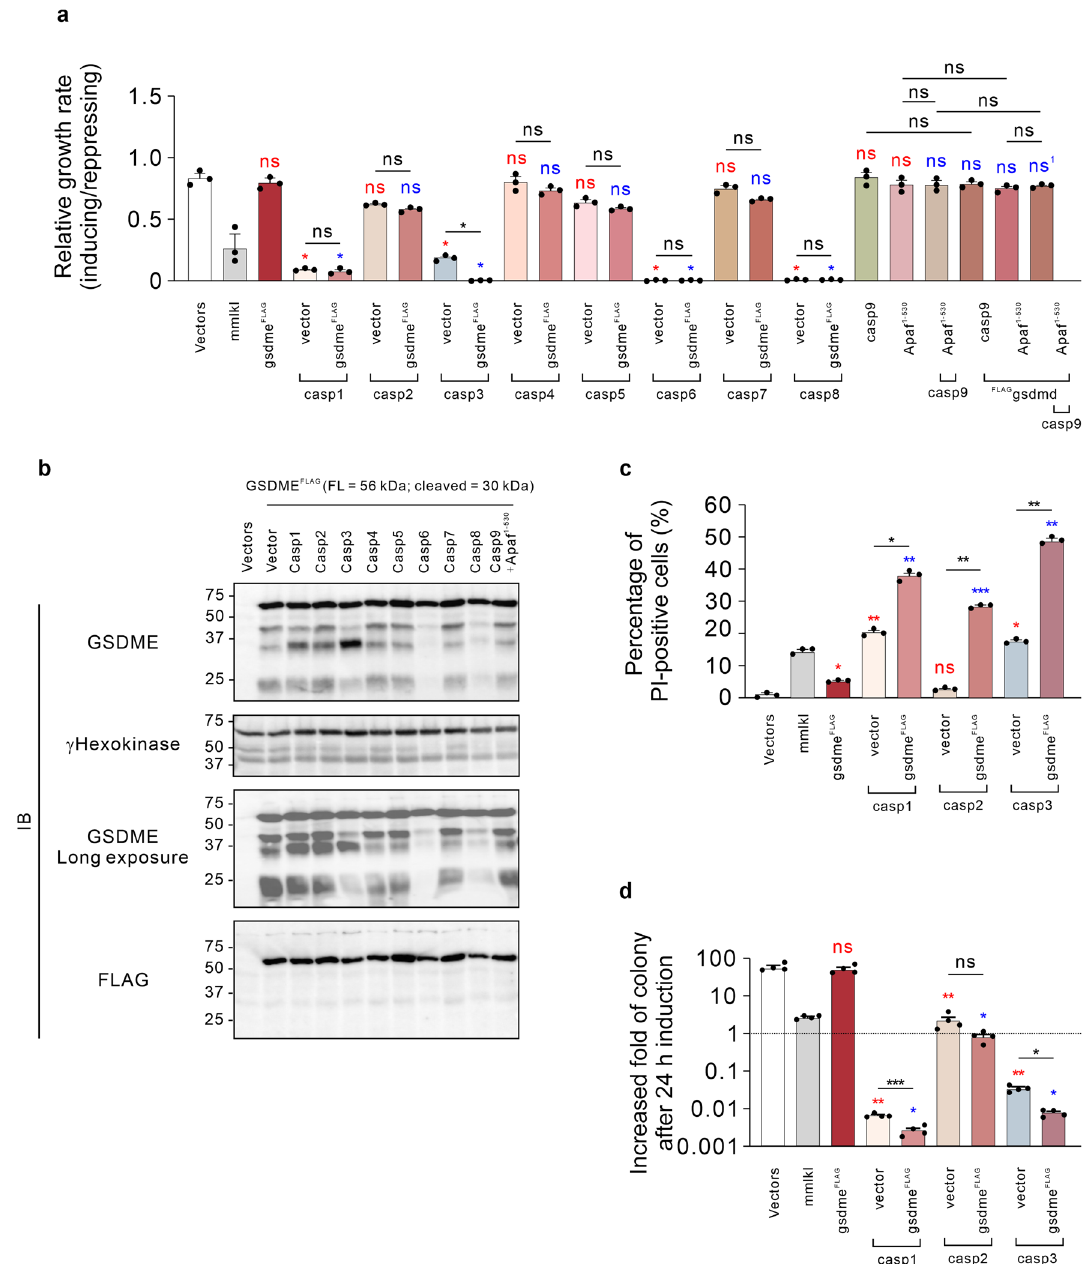
Figure 3. Reconstitution of GSDME-mediated pyroptotic cell death in S. cerevisiae . (a) Maximal growth rates of yeast bearing expression plasmids encoding GSDME FLAG and active caspases-1 to -9, or bearing empty vectors lacking cell death genes (labeled “Vectors”), were analyzed by monitoring rate of changes in absorbance of yeast cultured in inducing and repressing liquid media. ( b) Expression of recombinant expressed GSDME FLAG was assessed by western blot. Loading control: anti-γhexokinase. Uncropped blots are presented in Supplementary Fig. 4. ( c) Yeast bearing expression plasmids encoding GSDME FLAG and active caspase-1, -2, or -3 were grown under inducing conditions for 24 h then clonogenicity and membrane integrity were assessed. Following galactose removal, plasma membrane integrity of each yeast culture was assessed by propidium iodide (PI) uptake. ( d) The colony-forming abilities of post- induction cultures were expressed relative to the corresponding uninduced cultures. Cells were grown in inducing media for 24 h. Following galactose removal, the post-induction cultures were diluted and plated on solid repressing media and incubated for 3 days. Data present mean ± SEM of three ( a,c ) or four independent assays ( d ). Differences in maximal growth rates ( a ), PI-positive population ( c ) or fold-increases in colonies ( d ) of yeast bearing empty vector versus those expressing each transgene, or sets of 2 transgenes versus individual transgenes or pairs of transgenes were compared using ANOVAs with Sidak corrections. Comparisons made between yeast expressing each transgene(s) and empty vector yeast are labeled in red; Comparisons made between each transgene(s) to yeast expressing GSDME FLAG are labeled in blue, except for ns 1 in panel ( a) , in which the comparator was yeast co-expressing FLAG GSDMD and caspase-9. Other comparisons are indicated using black lines. *, P < 0.05; **, P < 0.01; ***, P < 0.001; ns, not